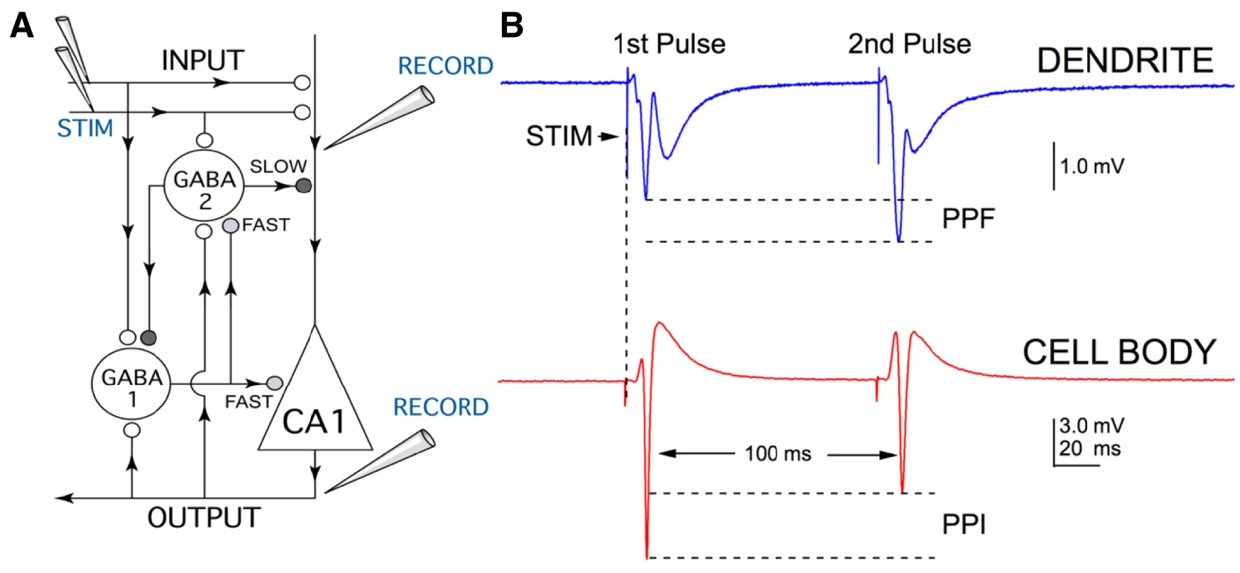
Figure 6. Diagram of inhibitory neuronal circuitry in the hippocampal CA1 region. ( A ) Schematic diagram showing a CA1 pyramidal neuron (triangle) and γ -aminobutyric acid (GABA)-mediated inhibitory interneurons (large circles). Glutamatergic synapses are represented using small open circles while GABAergic synapses are illustrated using shaded circles (light for ‘fast’ and dark for ‘slow’). The direction of information flow in axons and dendrites is indicated by arrows. For field excitatory postsynaptic potentials (fEPSPs), the recording electrode (RECORD) was placed in the apical dendrite region of the stratum radiatum. For population spikes (PS), the recording electrode was positioned along the axonal output side of the cell body layer of CA1 pyramidal cells (OUTPUT). Both fEPSP and PS responses were generated by stimulation with bipolar tungsten microelectrodes (STIM) placed on Schaffer collateral axons (INPUT). A paired-pulse stimulation paradigm with a 100 ms interpulse interval was used to assess the strength of GABA-mediated inhibition. ( B ) On the top is a recording showing paired-pulse facilitation (PPF) of fEPSPs, which results from increased excitatory glutamate release following the second stimulus pulse. A simultaneous recording on the bottom shows paired-pulse inhibition (PPI) of PSs, which results from enhanced inhibitory GABA transmission for the second pulse.